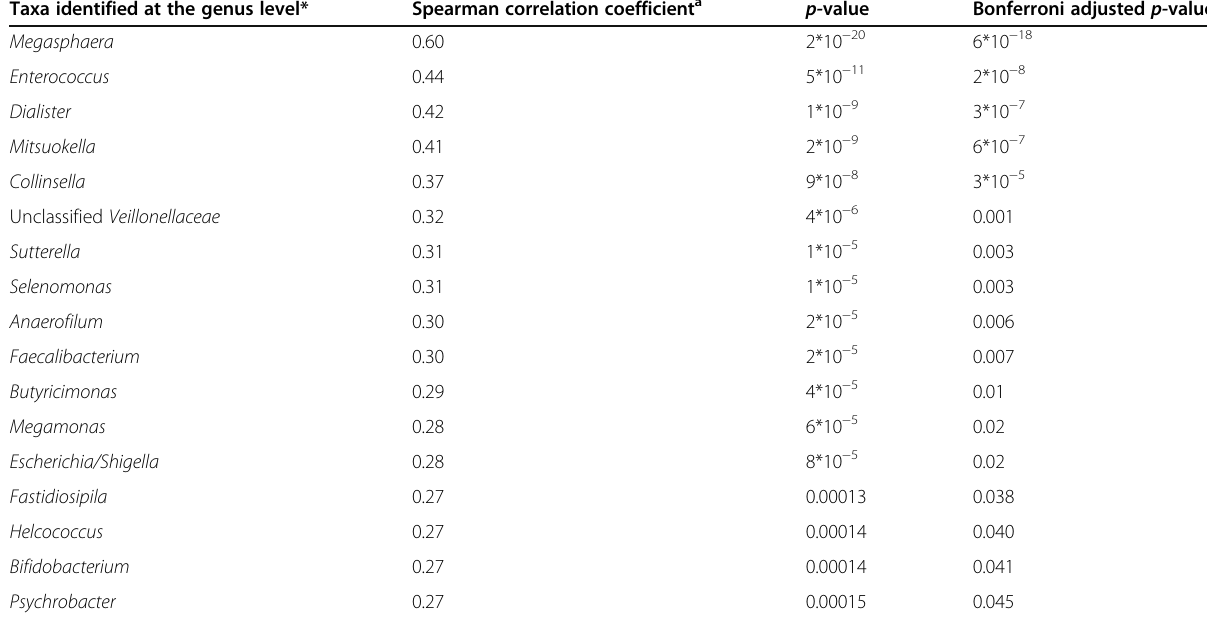
* Data represent the taxa identified at the genus level with a positive correlation with the dose of milk powder estimated on farms B and C. Only taxa with a significant correlation (Bonferroni corrected p- value <0.05) are shown a Spearman correlation coefficients ∈ [0.4; 0.6] indicate moderate to strong associations, whereas coefficients <0.4 indicate weak associations and were not considered for further